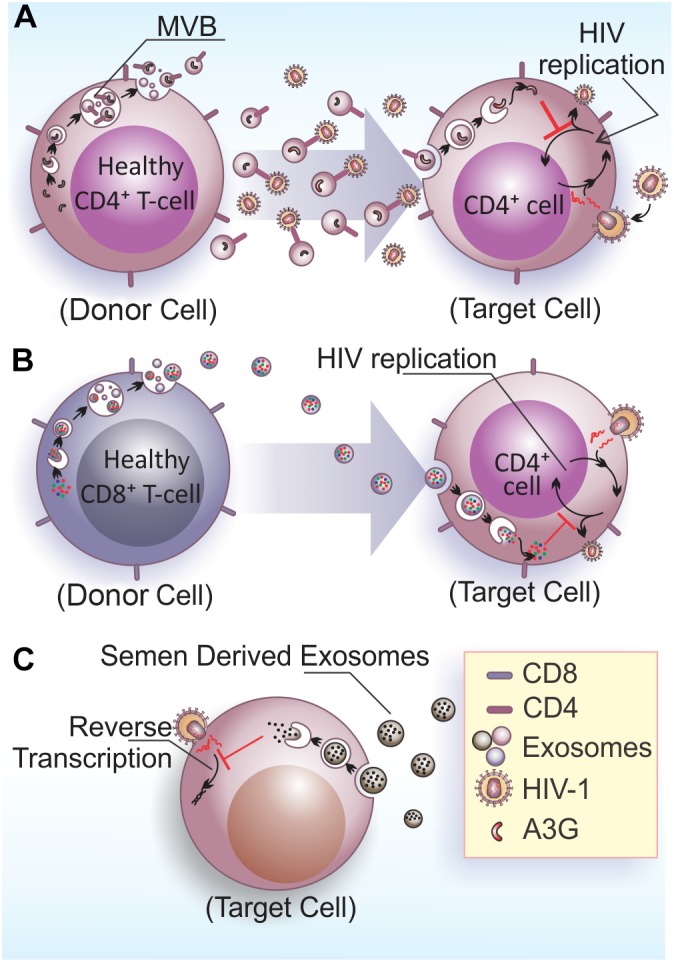
Anti-HIV-1 effects of EVs. (A) Exosomes released by healthy CD4+ T cells contains CD4 molecules on their surface and hinder HIV-1 infection/dissemination, possibly acting as decoys in the extracellular space. The viral factor Nef would neutralize this activity by reducing CD4 expression in EVs (De Carvalho et al., 2014). Additionally, exosomes also contain the enzyme A3G that can be internalized by infected cells and inhibit HIV-1 replication in target cells (Khatua et al., 2009). (B) Exosomes released from CD8+ T cells have non-cytotoxic antiretroviral activity that inhibits HIV-1 transcription in target cells (Tumne et al., 2009). (C) Semen derived exosomes are internalized by target cells (vaginal epithelial cells) and are able to block HIV-1 replication through the impairment of viral RNA reverse transcription (Madison et al., 2014).